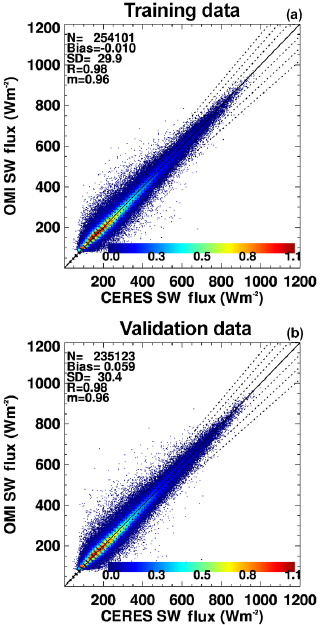
Figure 6. Two-dimensional histogram similar to Fig. 5 but showing training (top) and validation (bottom) results from the combined all-sky NN models (input parameters listed in Fig. 3, model “h” for f c <1 and as in Fig. 3 for f c >1) as final selected models for estimation of TOA SW flux. The data from two NN models have been combined in these plots. These are instantaneous flux values averaged over 1 ◦ × 1 ◦ grid boxes. Data from the 1st day of each month of 2007 are used for training and data from the 16th day of each month of 2007 are used for validation. The three dotted lines are 5, 10, and 15% error envelope lines.